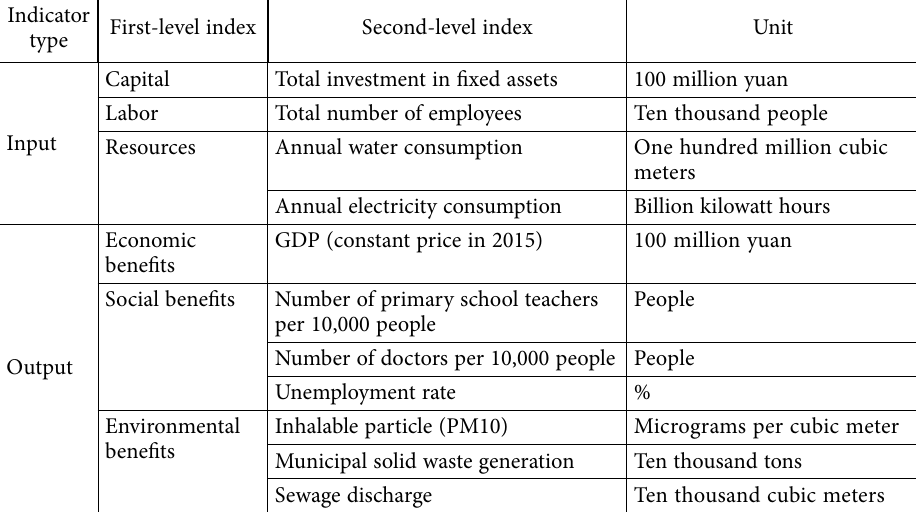
Table 1. Evaluation index system for green development in the